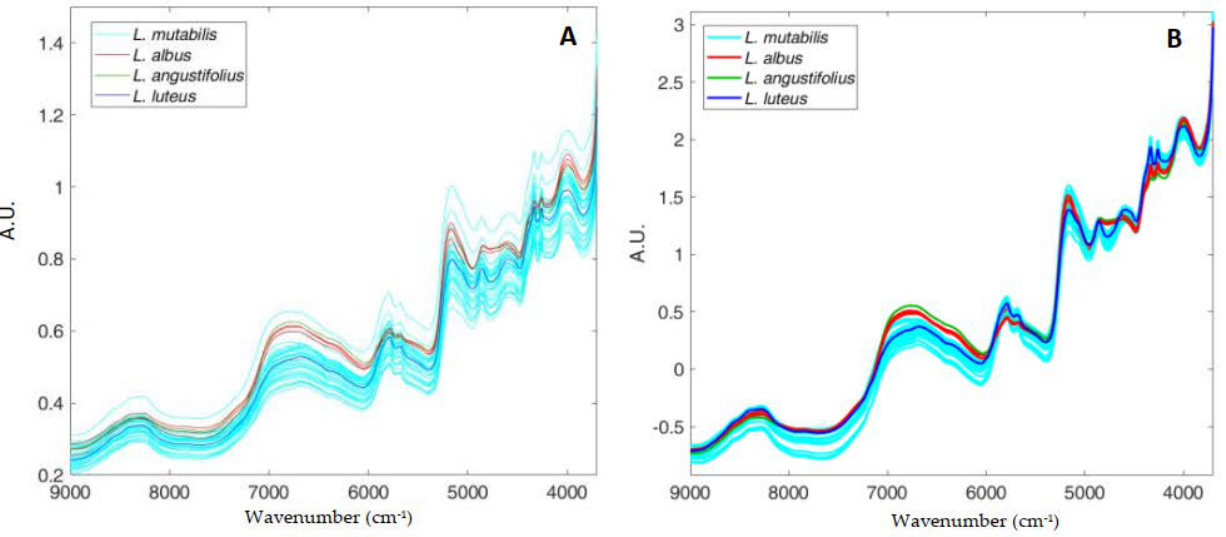
Figure 4. FT-NIR spectra collected for the 33 L. mutabilis ecotypes, three L. albus (cv. Dulce 7, Ares and Multitalia), one L. angustifolius (cv. Boregine) and one L. luteus (cv. Percoz): ( A ) raw spectra; ( B ) FT-NIR spectra after the SNV